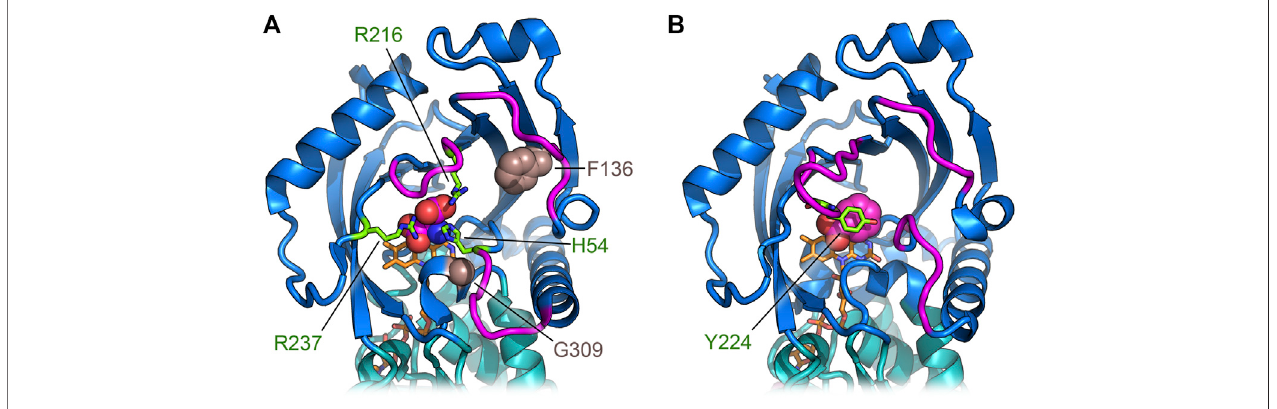
FIGURE 5 | Comparison of the regions deputed to control the active site entrance in hDASPO (A) and hDAAO (B) . The loops close to the active site entrance are showninmagenta;inhDASPOtheresiduesPhe136andGly309,correspondingtopositionsrelatedtosomaticmutationincancer,areshownassphere;FADcofactoris shown in